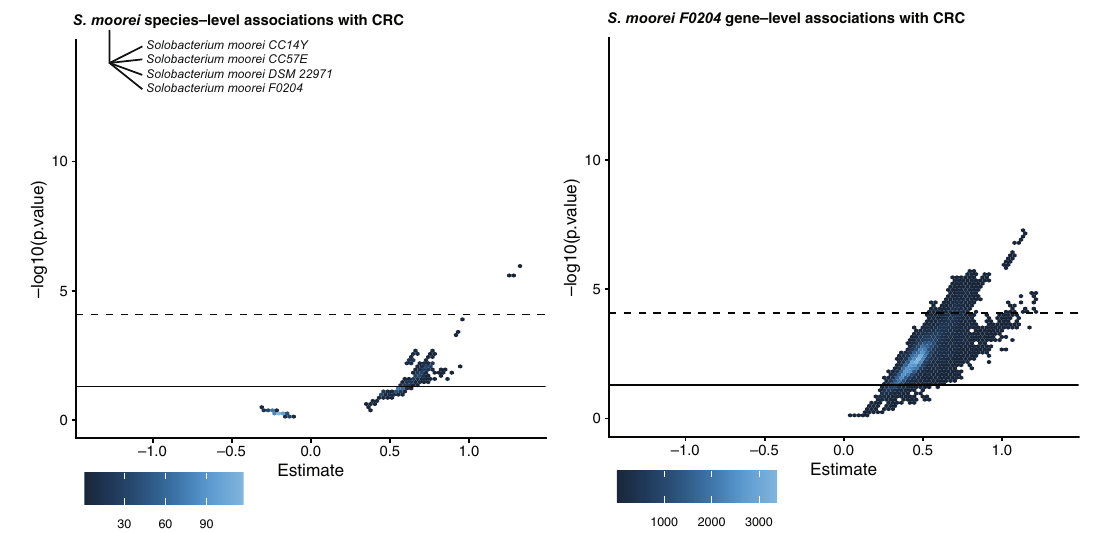
Fig. 6 Vibration of an association with CRC at the species versus gene level. Each point corresponds to a different linear model speci fi cation. Y axes are log 10 P values. Solid line is nominal statistical signi fi cance ( P < 0.05). X axes are the beta-coef fi cient on the binary, independent disease variable of interest. The dotted lines correspond to the 0.05 false-discovery rate-adjusted log 10 cutoff (for species and genes, respectively) in our original meta-analysis, whereas the solid line corresponds to the nominal ( P = 0.05) cutoff. The gene-level plot (right) contains the overlaid vibration output for every S. moorei gene ( N = 662, all deriving from one strain) that was signi fi cantly associated with